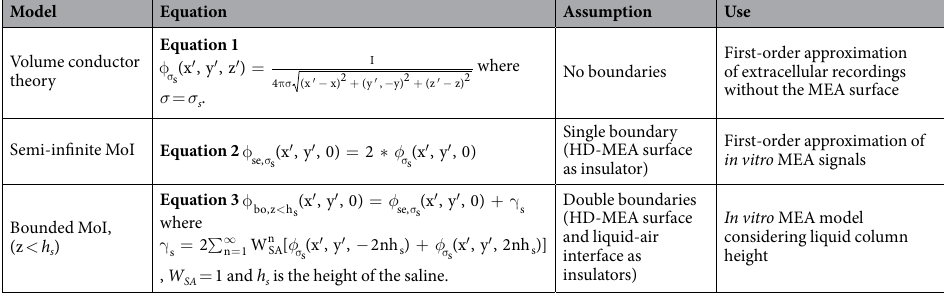
Table 1. Equations to model HD-MEA signals in isotropic media.